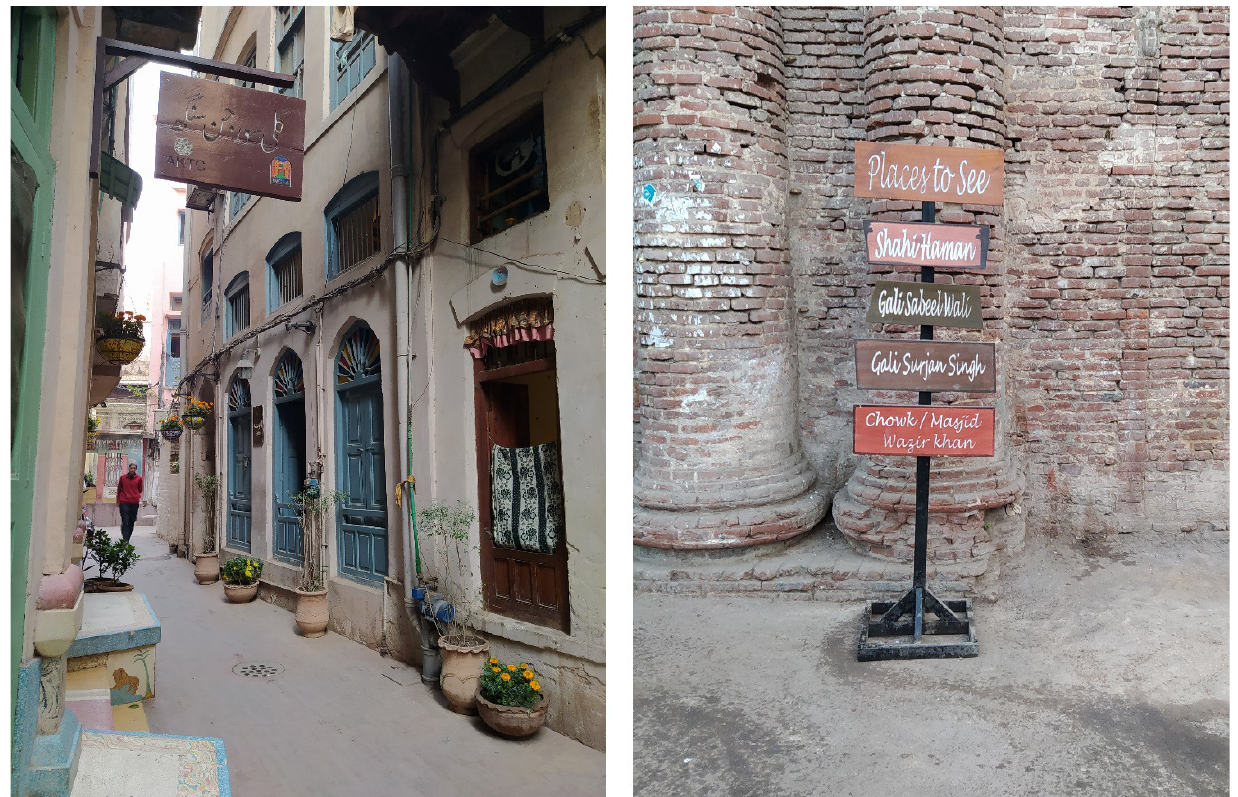
Figure 8. Mohalla Gali Surjan Singh on the left and sign plates announcing touristic places in the Royal Trail on the right. Photos by author Helena Cermeño (2021).